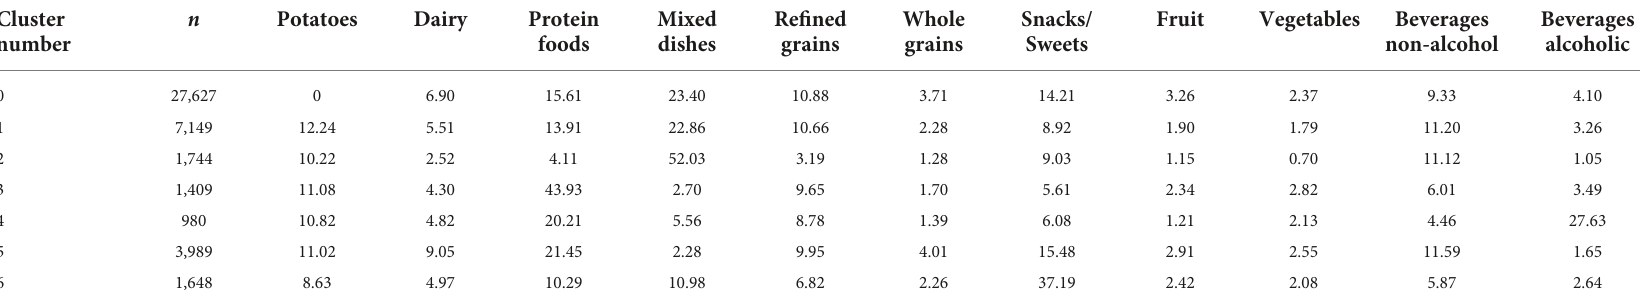
n Potatoes Dairy Protein